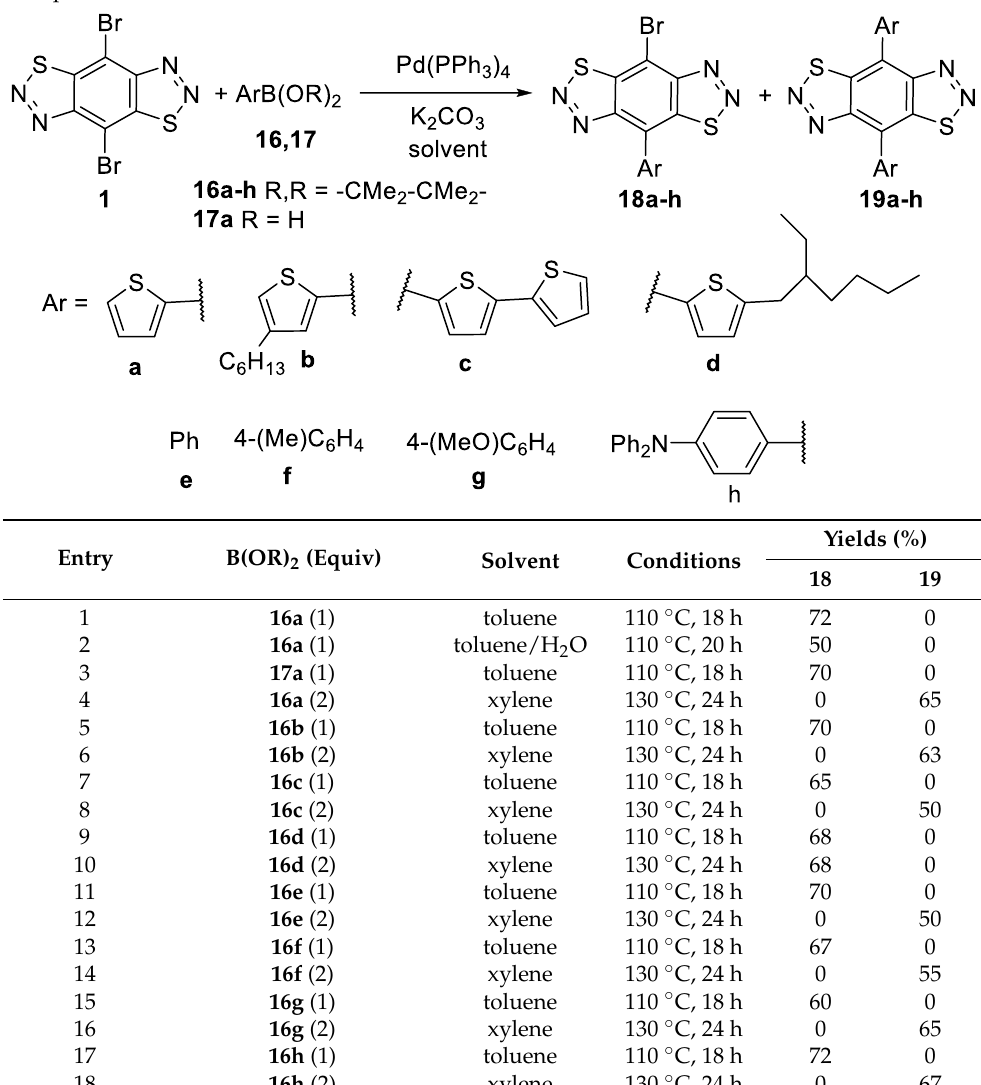
Table 5. Suzuki – Miyaura cross-coupling of 4,8-dibromobenzo[1,2- d :4,5- d ’ ]bis([1,2,3]thiadiazole) 1 Table 5. Suzuki–Miyaura cross-coupling of 4,8-dibromobenzo[1,2- d :4,5- d ’]bis([1,2,3]thiadiazole) 1 with pinacolate esters 16a – h and boronic acid 17a . with pinacolate esters 16a – h and boronic acid 17a .